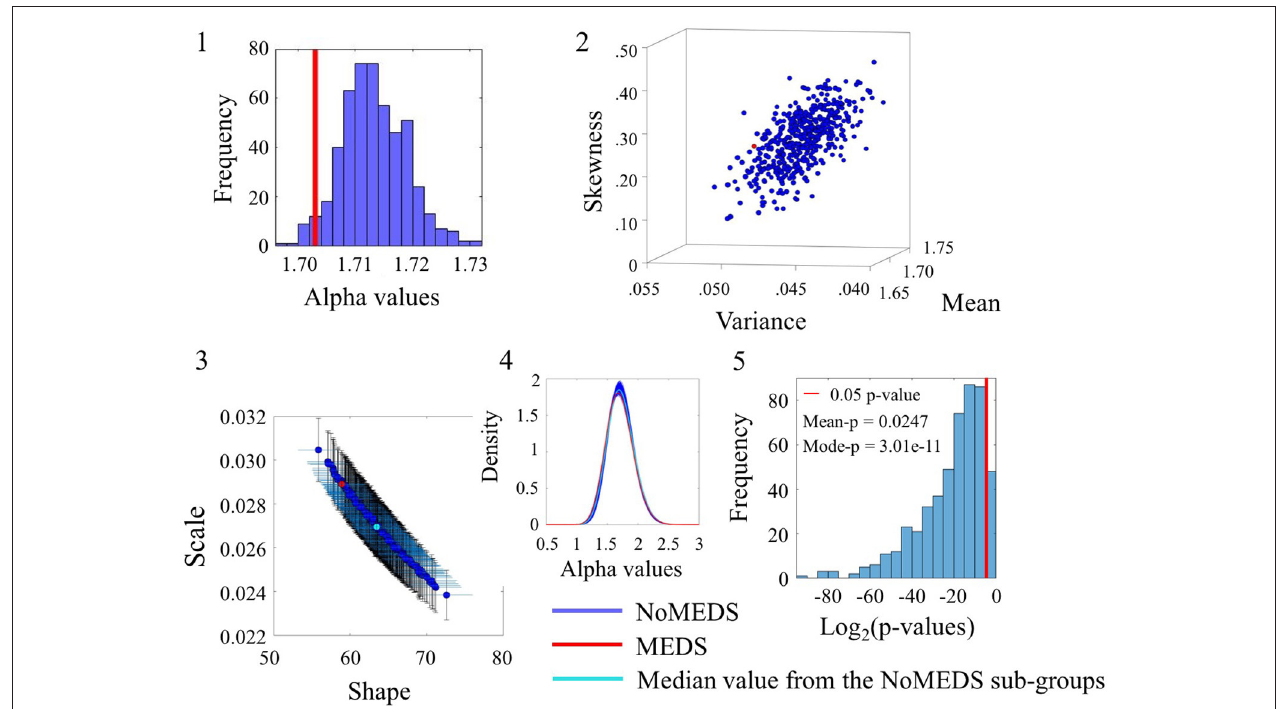
FIGURE 8 | Comparison between Meds and NoMeds for the Linear Speed (SR0 groups). Figure format similar to Figures 4 – 7 .